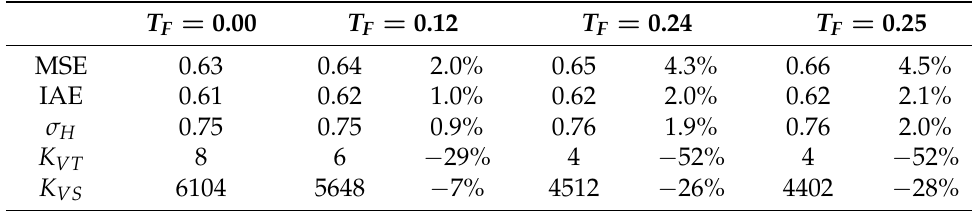
Table 15. Control error filter impact on G 3 ( s )